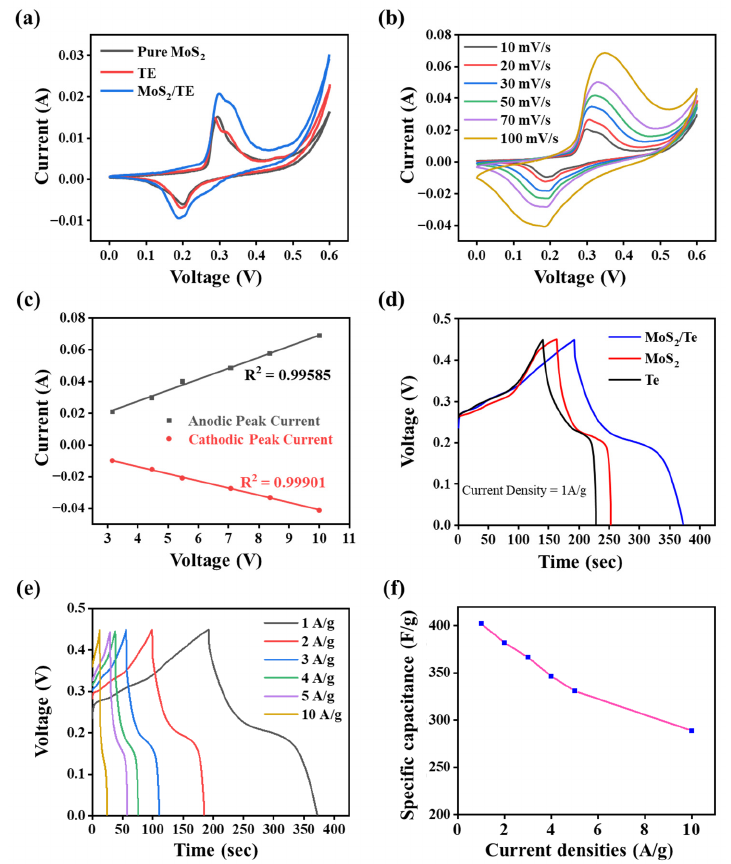
Figure 6. Electrochemical performances: ( a ) CV profiles for different nanoparticles and composites (scan rate: 10 mV/s, potential: (0–0.6) V, and ref. electrode: Ag/AgCl), ( b ) CV profiles for MoS 2 /Te at different scan rates, ( c ) anodic and cathodic peak current vs. Sq. root of scan rates, ( d ) GCD profiles of different nanoparticles and composites, ( e ) GCD profiles for MoS 2 /Te at different current densities, and ( f ) specific capacitance of MoS 2 /Te at different current densities. The data are presented as the mean ± SD ( p < 0.05).